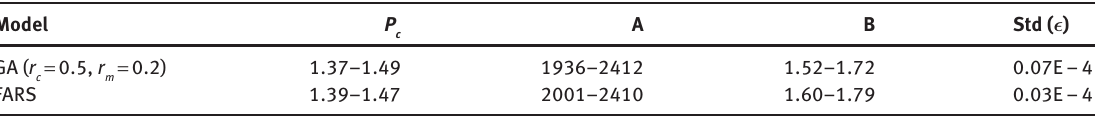
Table 5: Variation Ranges of Optimized Model Parameters and Performance Standard Deviation for GAs and FARS within the 100 Performed Optimization Runs.